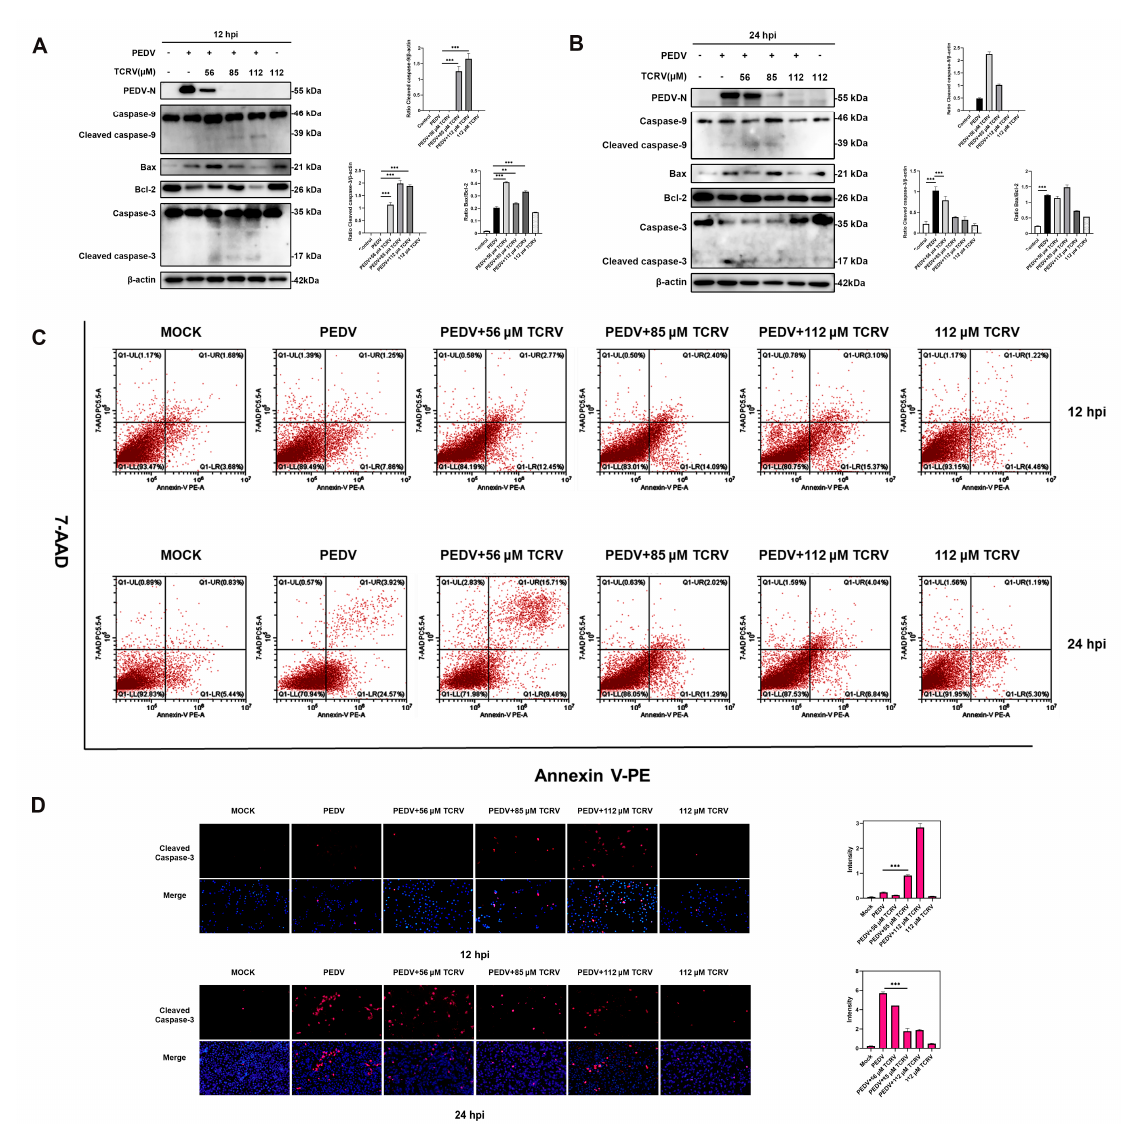
Figure 4. The apoptosis induced by TCRV in PEDV-infected cells is different from PEDV-induced apoptosis. ( A , B ) Western blotting analysis of PEDV N, caspase-3, -9, Bax, and Bcl-2 proteins in PEDV-infected Vero cells treated with the indicated concentrations of TCRV at 12 hpi and 24 hpi. Results were presented as the ratio of band intensities of the target protein to β -actin. ( C ) PEDV- infected cells were treated with the indicated concentrations of TCRV at 12 hpi and 24 hpi. Apoptosis was analyzed using Annexin V-PE/7AAD staining, and the apoptotic cells were explored using flow cytometry. The Annexin V-positive cells were considered apoptotic cells. ( D ) The treatment of PEDV-infected cells with TCRV at concentrations of 56 µ M, 85 µ M, and 112 µ M. Cells were processed for immunofluorescence using antibodies against cleaved caspase-3 protein and DAPI staining. Data from three independent experiments and error bars are presented as the mean ± SEM. ** p < 0.01, *** p <